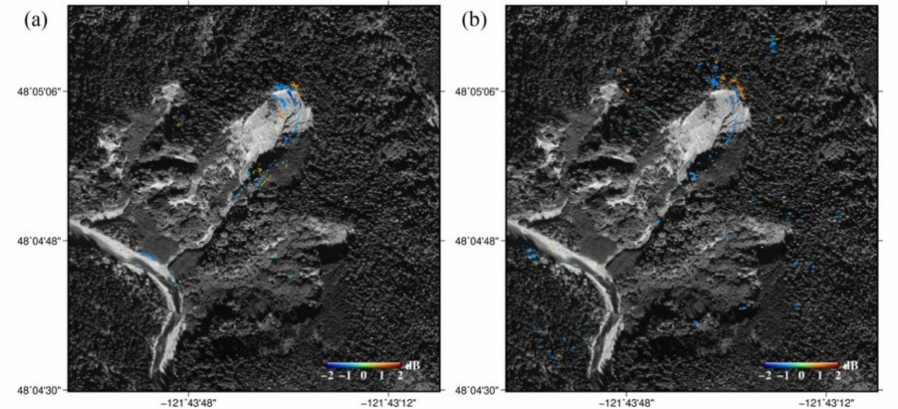
Figure 9. TerraSAR-X intensity change between 2017 and 2018 ( a ) and between 2018 and 2019 ( b ) in the Gold Basin landslide. Cool color indicates intensity decrease and warm color intensity decrease